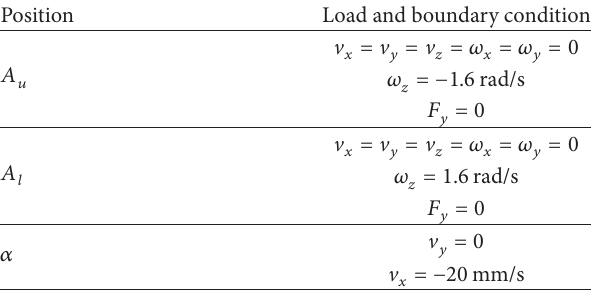
Table 2: Loads and boundary conditions for phase I.